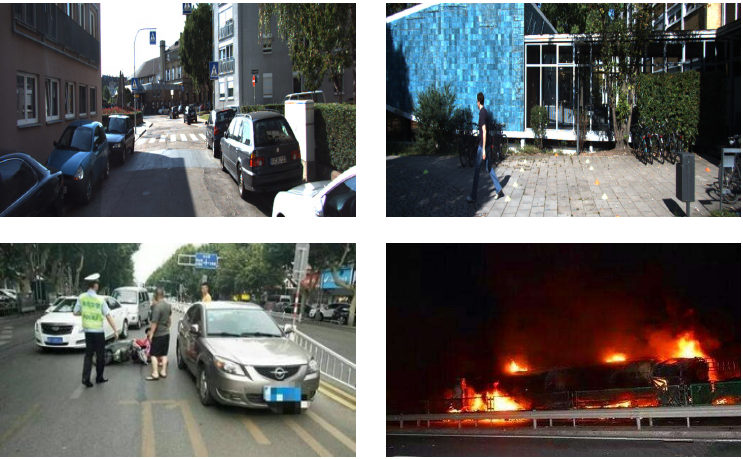
Figure 1. The figure shows examples of data sets of cars, pedestrians, traffic accidents and fires. In order to achieve better practical detection of convolutional neural networks, a data augmentation method is used to make the network label categories more balanced. Based on the distribution of the different types of existing labels, we target categories with a low number of labels (e.g., trucks, traffic accidents) and add images containing such labels. In the process of adding samples, we selectively added images in rain and fog scenes, as shown in Figure 2. The statistics of each type of label after enhancement are shown in Figure 3.